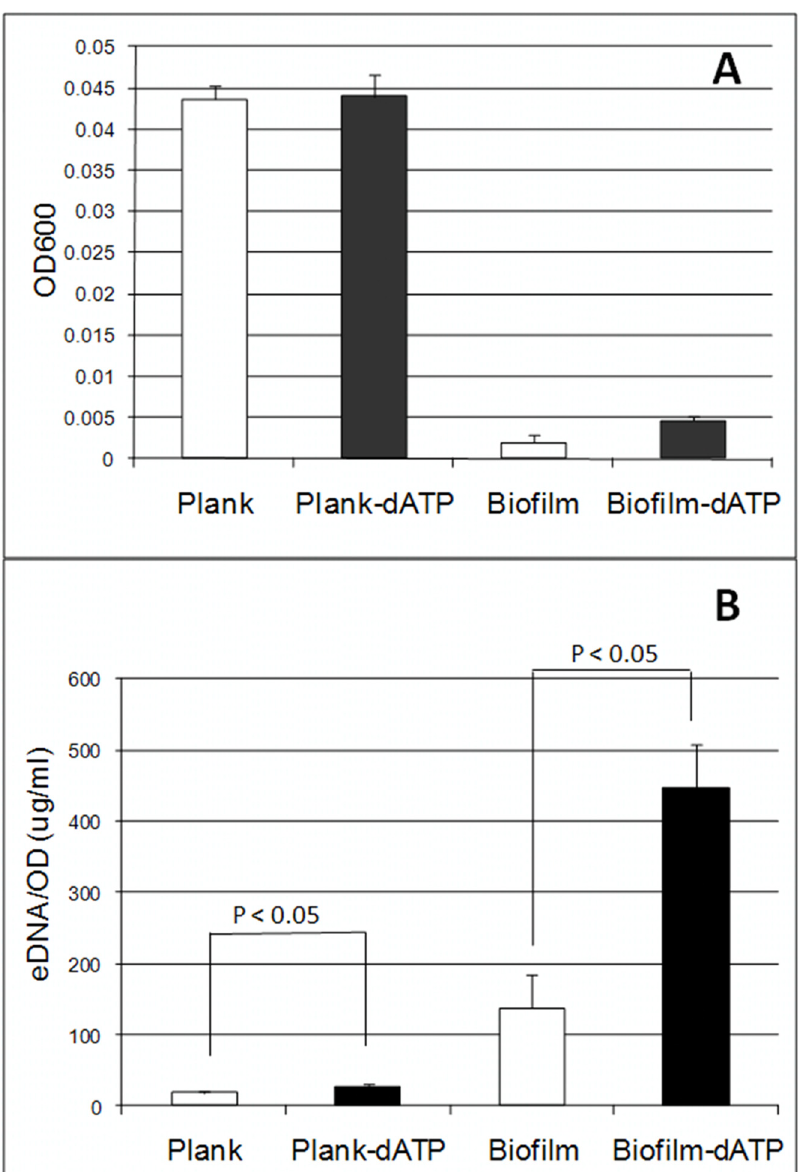
Figure 4. Growth of E.coli K-12 in suspensions and biofilms and eDNA released in suspended cultures and biofilm matrix in 10% LB supplemented with or without dATP (400 m M). A, growth of E.coli K-12 in suspensions and biofilms; B, eDNA in cultures and biofilm matrix. eDNA was extracted using the method we developed (see the Materials and Methods section) and quantified using the PicoGreen dsDNA Quantitation Kit (Molecular Probes, Invitrogen). P values from statistical analysis of three independent experiments were shown in the graph. Student T-test was used for statistic analysis.